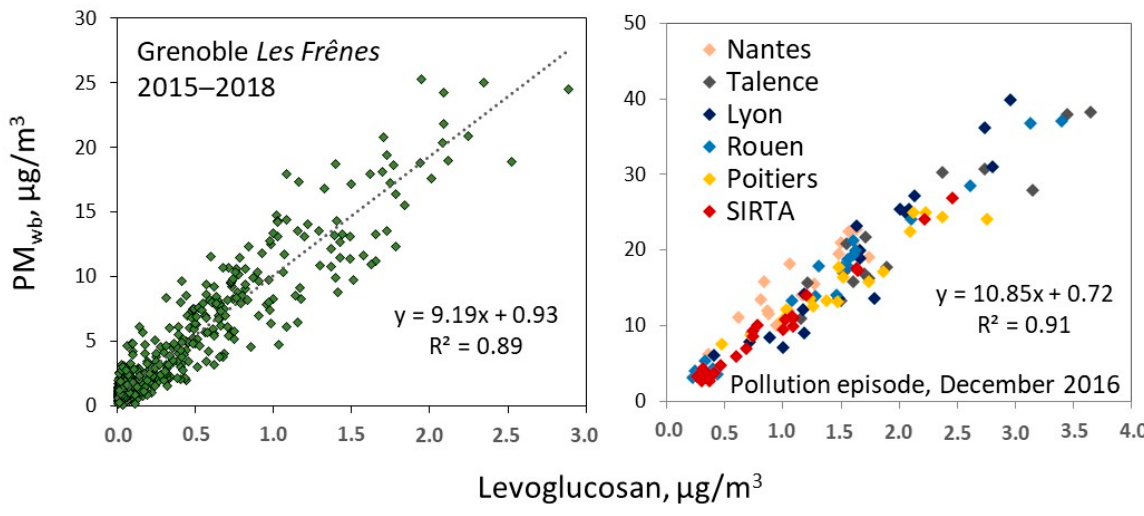
Figure 12. Comparison between PM wb (estimated from AE33 measurements as described in Section 2.3) and offline filter- based levoglucosan measurements in Grenoble over the period 2015–2018 (every third day) and at different sites of the CARA program during the December 2016 pollution episode (daily